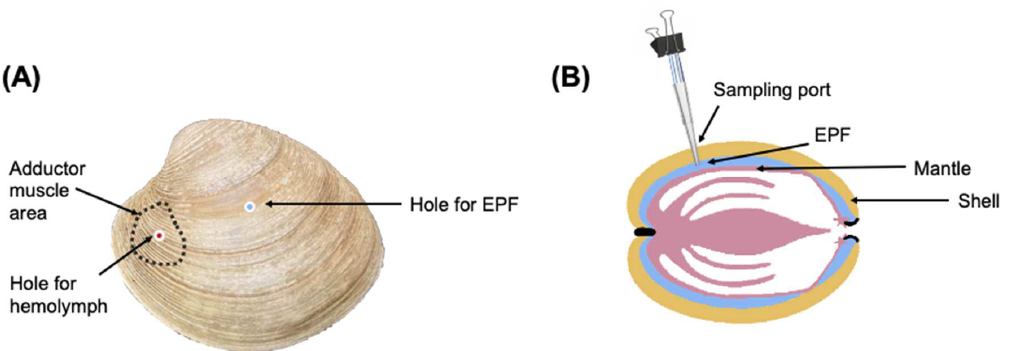
Figure 5. ( A ) Holes for accessing hemolymph and EPF. ( B ) Installation of sampling